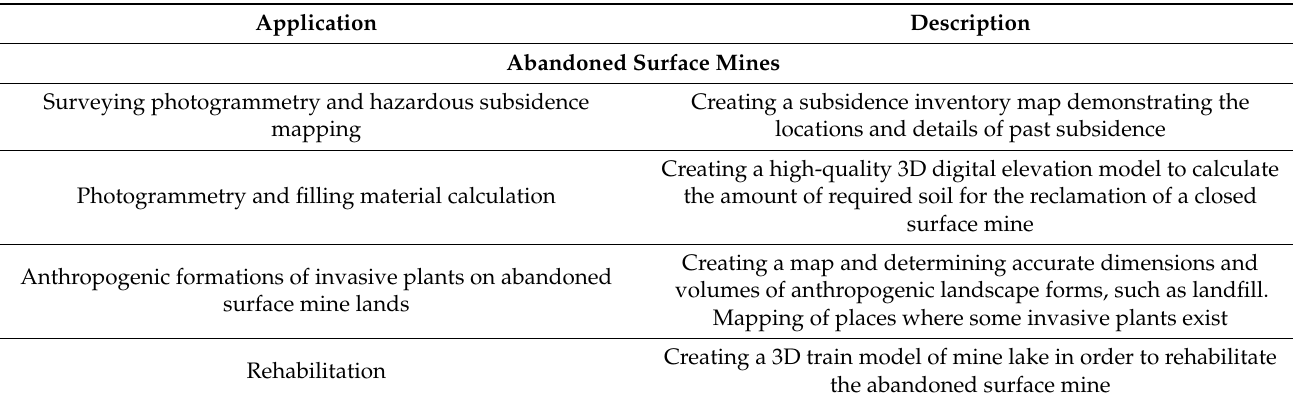
Table 2. Applications of drone technology in mining missions (Adapted from Ref.